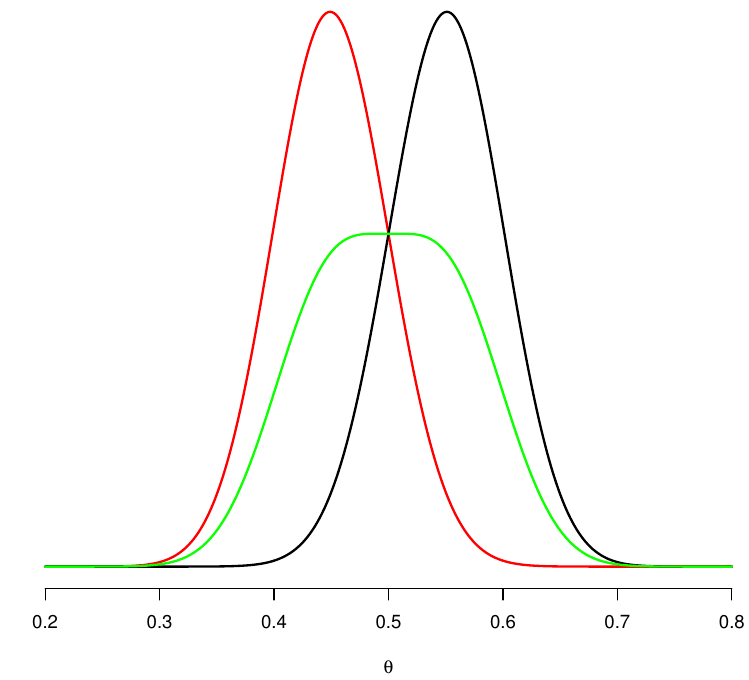
Figure 2. Level of certainty of two hypothetical experts (red and black curves) and their mean (green curve). Note that, when the location parameters of the experts’ distributions are different, those of the resulting mean distribution (green curve) may be considerably different from the experts’ actual